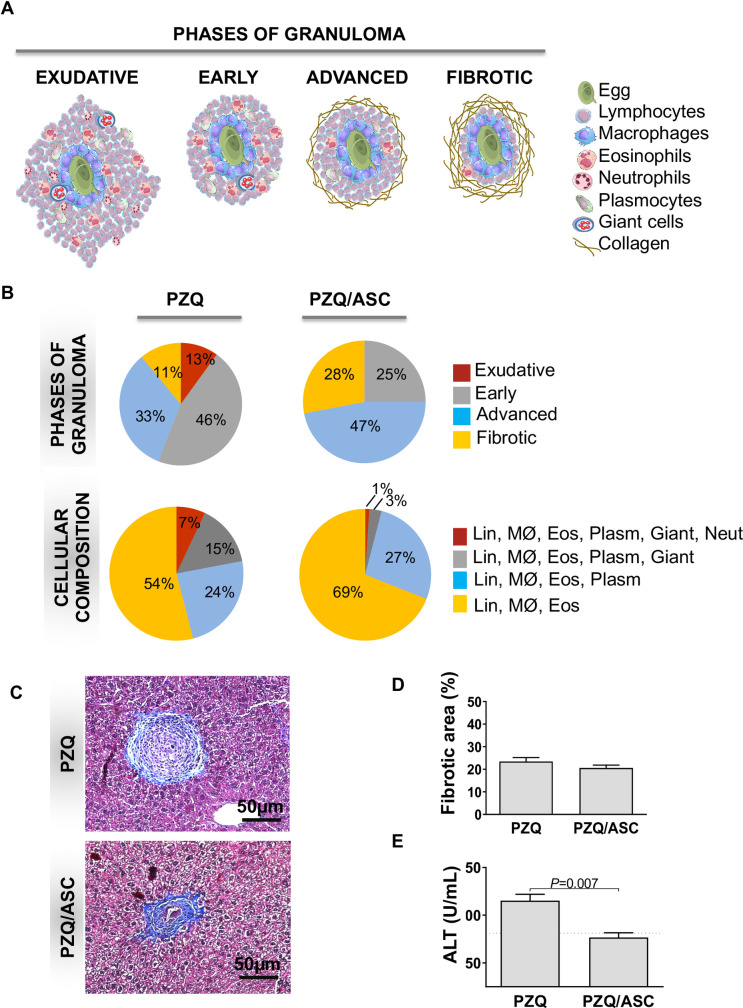
ASC therapy effect on granulomas and ALT levels.Panel A shows a schematic representation of the phases and cellular composition of granulomas. The exudative phase is characterized by the establishment and organization of the granulomatous reaction with focal destruction of the vessel walls involved and/or adjacent parenchymal and abundant presence of eosinophils, macrophages and other immunologic cells. The early phase is characterized by the presence of giant cells and the dissociation of collagen fibers. An increase in collagen characterizes the advanced phase. Fibrosis is characterized by a significant decrease in cellular composition and thickening of the collagen layer. Panel B shows the comparative analysis of the phase and cellular composition of the granulomas in PZQ and PZQ/ASC groups. Panel C shows representative images from the liver granulomas stained with Masson’s trichrome. Panel D shows fibrotic area in the liver. Panel E shows the levels of ALT in sera of Schistosoma-infected C57BL/6 mice treated with PZQ or PZQ/ASC, expressed as the mean ± standard deviation. The horizontal lines indicate statistically significant differences between the groups (p<0.05). PZQ = Praziquantel-treated group. PZQ/ASC = Praziquantel plus adipose tissue-derived stem cells-treated group.